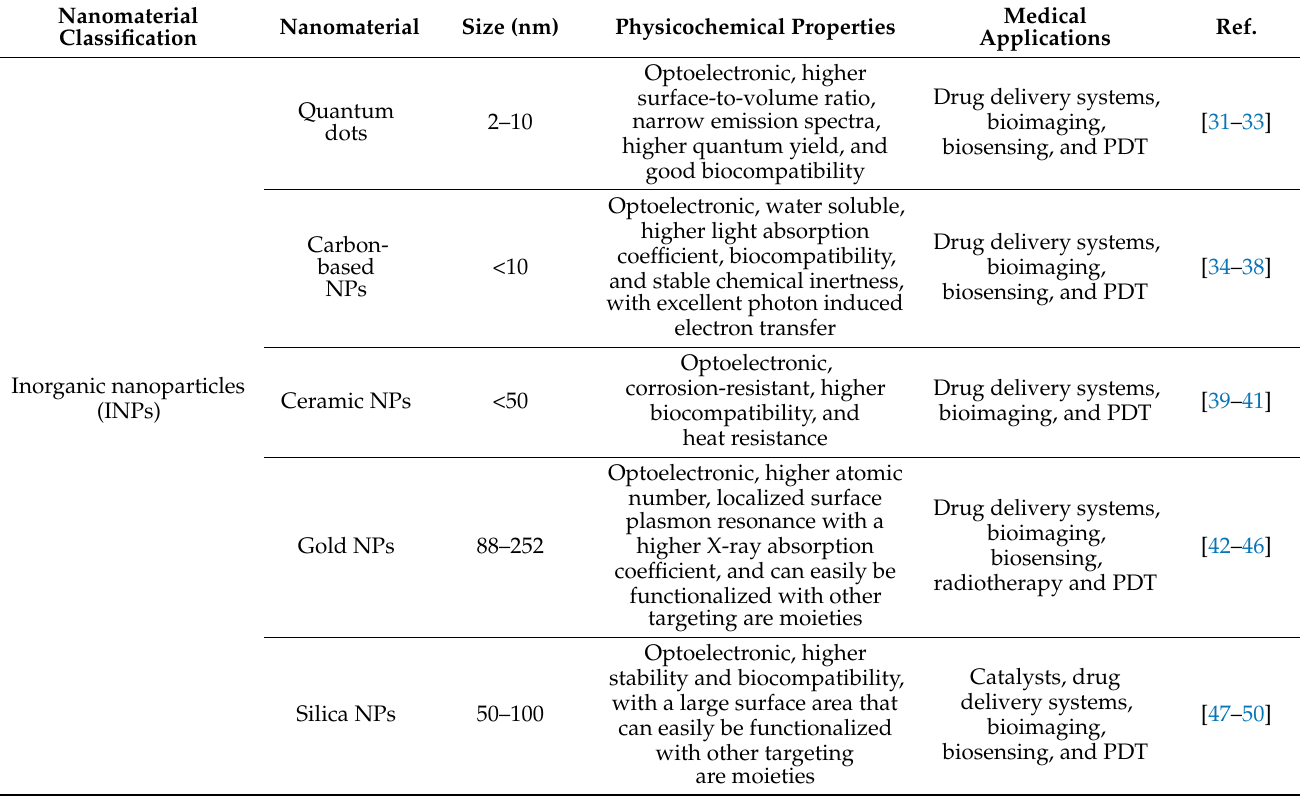
Table 3. Classification and characteristics of nanomaterials used in cancer